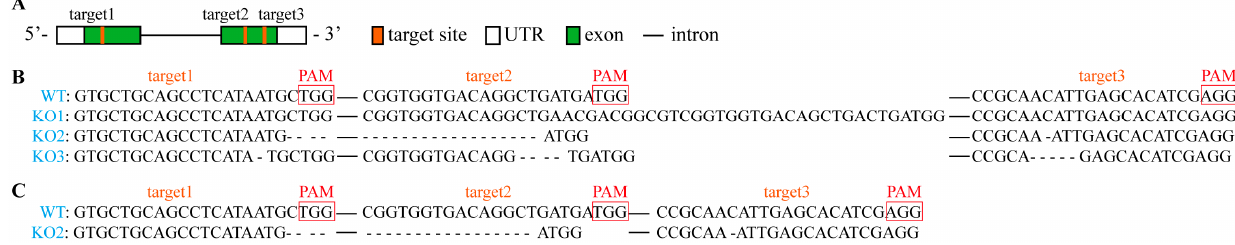
Figure 1. Knockout of PCP using CRISPR/Cas9 system. ( A ) The gene structure of PCP and three target sites (orange boxes) in the first and second exons of PCP for CRISPR/Cas9 editing. ( B ) Sequences of leaves in three homozygous knockout lines (T2) with deletions in target sites that truncated the PCP ORF ( KO1 , KO2 and KO3 ). ( C ) Sequences of pollen in KO2 line (T3). The sequence of the wild type is shown at the top. Target sites and protospacer-adjacent motif (PAM) sequences are highlighted in red, and the deletions are indicated by dashes. The sequence gap length is shown in solid lines.